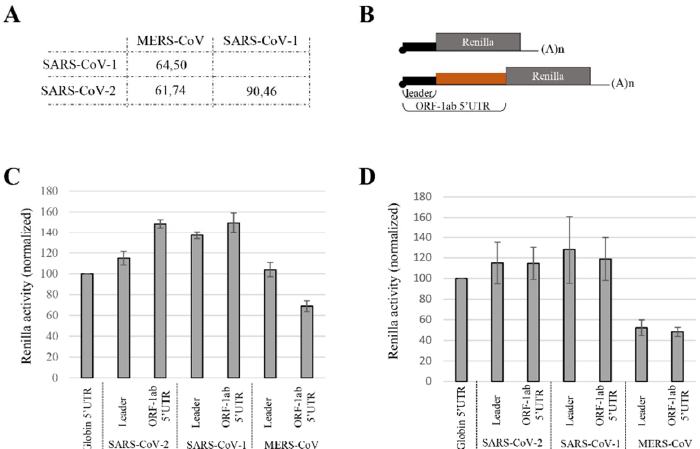
Figure 4. Divergence in translation efficiency between the 5 (cid:48) UTRs of MERS-CoV and SARS-CoV gRNA. ( A ) Percentage of identity between the 5 (cid:48) UTRs of MERS-CoV, SARS-CoV-1 and SARS-CoV-2 gRNAs resulting from a MUSCLE alignment (Figure S2). ( B ) Scheme of capped and polyadenylated mRNAs coding for the Renilla reporter gene with the leader or the 5 (cid:48) UTR ORF1ab from SARS-CoV-1/2 and MERS-CoV. ( C ) RRL was programmed with the corresponding in vitro transcribed reporter mRNAs. Expression products were quantified by luciferase assays and normalized to globin 5 (cid:48) UTR expression (set at 100%). ( D ) Jurkat cells were electroporated with capped and polyadenylated mRNAs as indicated. After 90 min of incubation, the cellular extracts were used for luciferase assay and RT-qPCR. All the results are normalized to the globin 5 (cid:48) UTR expression (set at 100%). Values shown are the mean (+/ − S.E.M.) for 6 ( C ) and 5 ( D ) independent experiments.